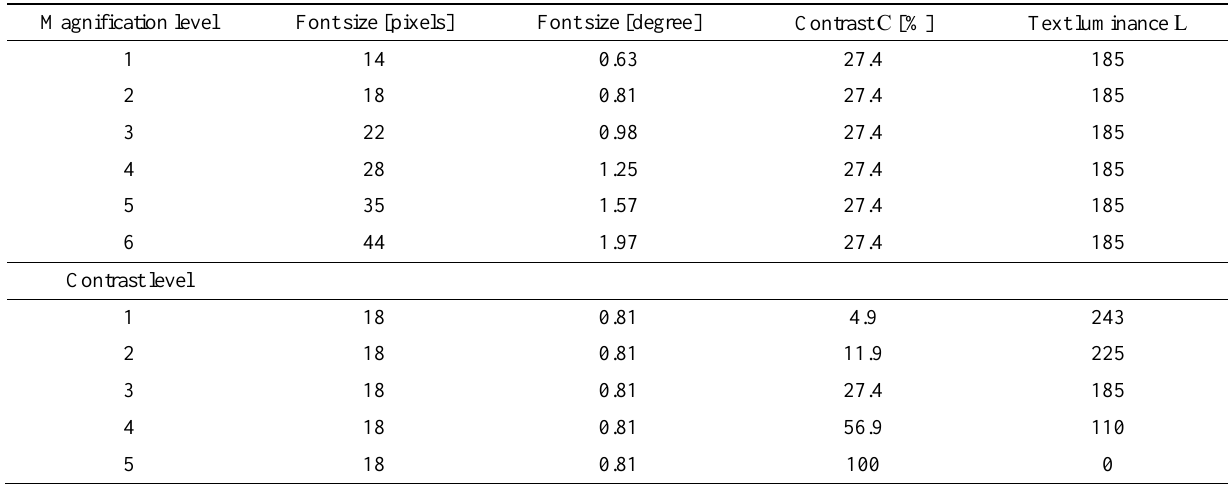
Table 1. Size and contrast characteristics of the tested levels